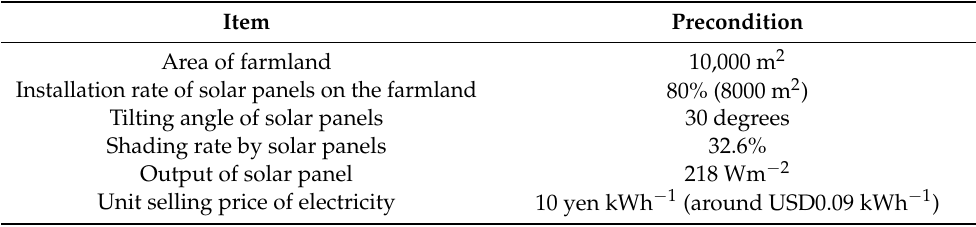
Table 1. Preconditions for the calculations.